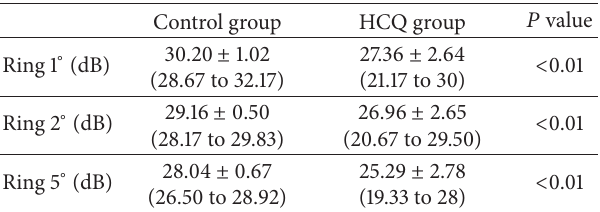
Table 2: Mean retinal sensitivity in each ring of the grid presented for the two groups of the analyzed sample for both